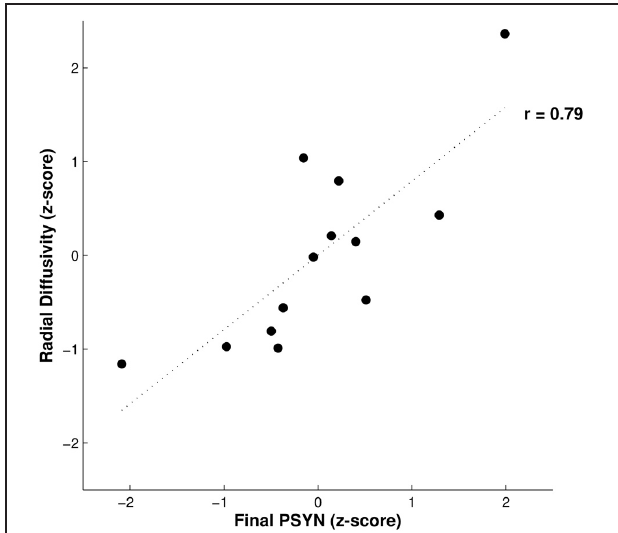
FIGURE 3 | Relationship between radial diffusivity and final performance on PSYN. This plot depicts the partial correlation between final PSYN and radial diffusivity extracted from the significant correlation with FA in bilateral sensorimotor cortex ( Figure 2 ) after the effects of age have been removed. Each value is a residual converted to a z -score, and represents individual scores. The dotted line represents the best fit linear regression line through the data ( r = 0 . 79, p < 0 . 005).